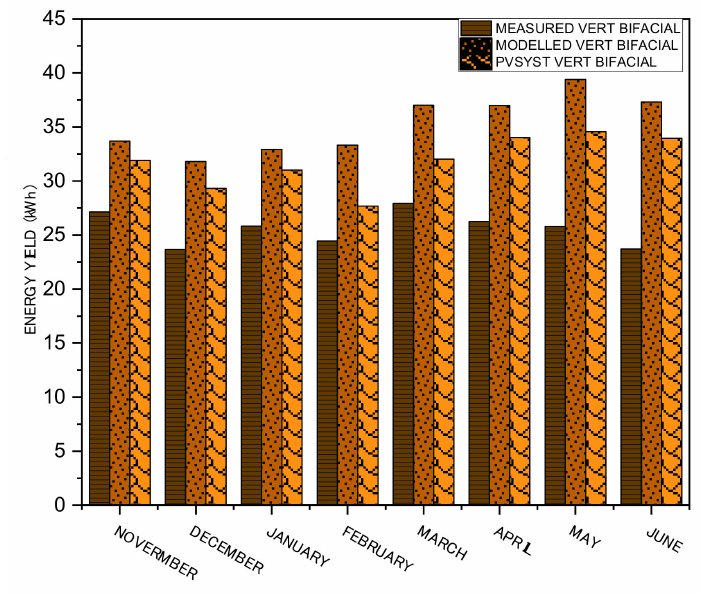
Figure 5. Measured, modelled, and PVsyst monthly energy yield of the vertical bifacial PV system.